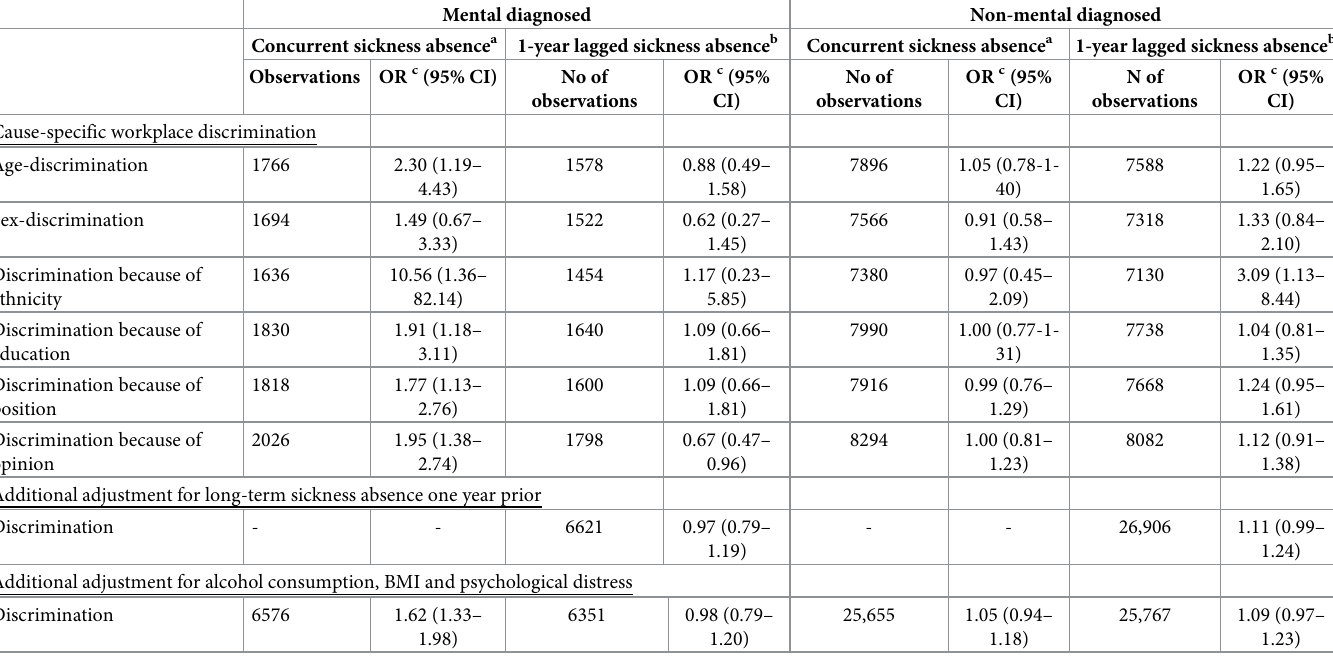
Table 4. Changes in cause-specific workplace discrimination and odds for concurrent and 1-year lagged long-term sickness